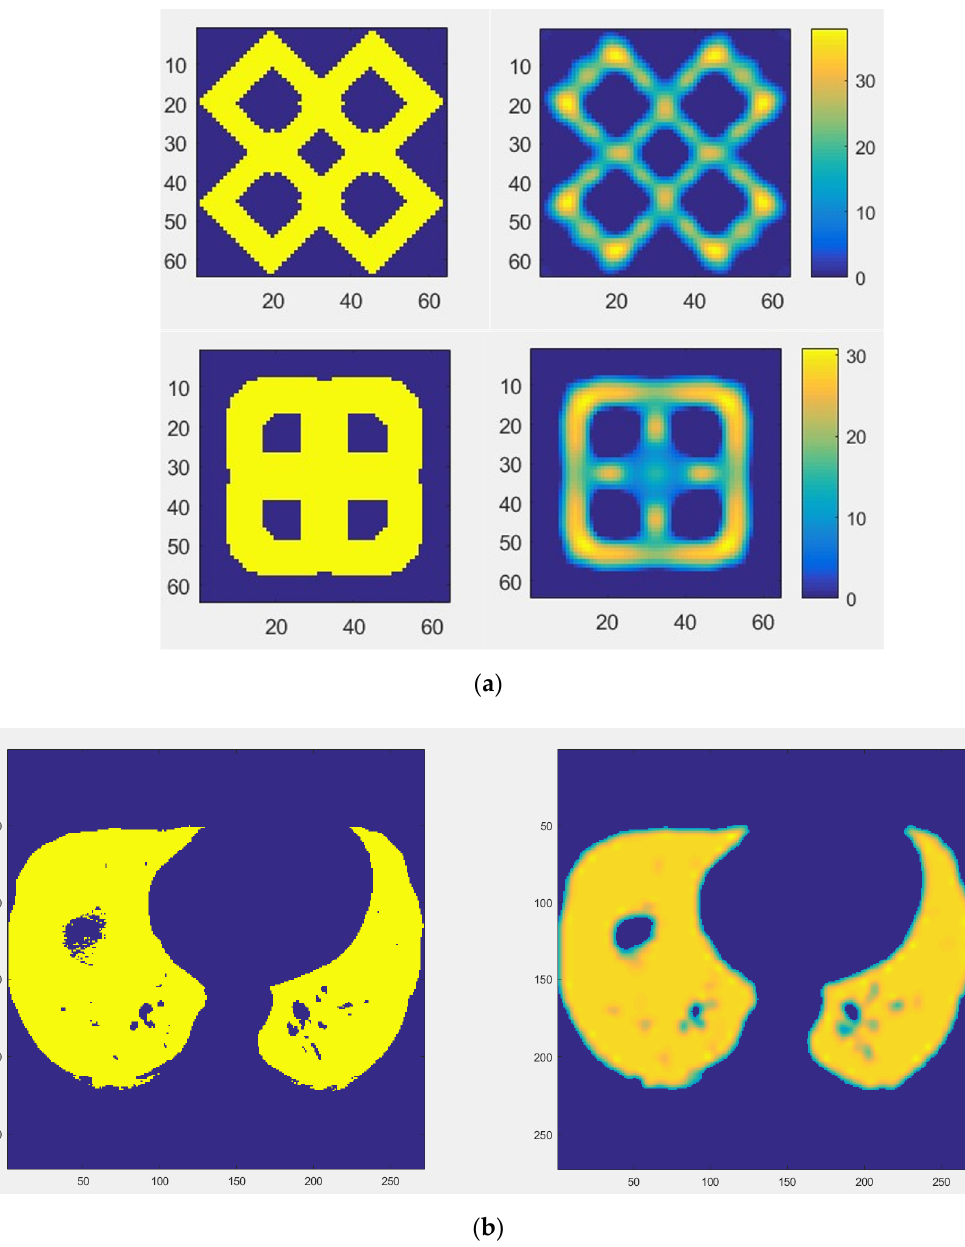
Figure 13. Examples of image reconstruction: ( a ) direct decompression with filtering, ( b ) reconstruction of a complex shape derived from computed tomography of the lung.